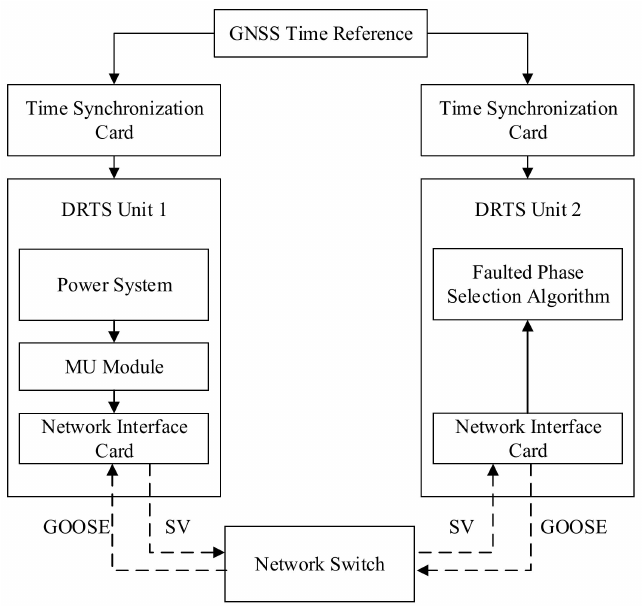
Figure 8. Schematic of the setup for testing transient-based scheme. IEC 61850-9-2 LE SV, published by the network interface card of the DRTS unit 1 (simulating the power system), was directed through a local area network (LAN) to DRTS unit 2, which ran the transient-based phase selection algorithm. The SV packets were published at a sampling rate of 256 samples per cycle (s/c), which translated to a sampling frequency of 15.36 kHz with a system nominal frequency of 60 Hz. The merging unit was modeled assuming an analog to digital (A/D) converter bit resolution of 24 bits. Anti- aliasing filters of the merging unit were modeled as the sixth-order low-pass Butterworth filters with the cutoff frequency set to half of the sampling frequency of 15.36 kHz. The lower and upper cutoff frequencies of the band-pass filter used in the phase